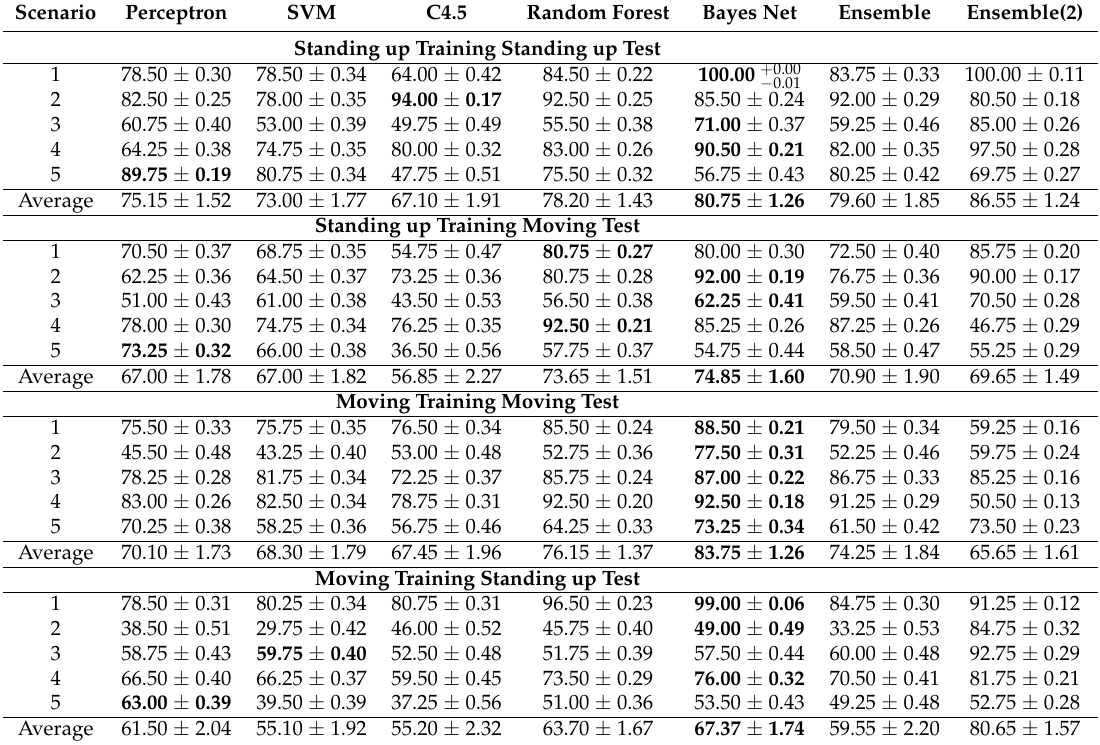
Table 3. Performance results for the five different Machine Learning classifiers (data shown in percentages. Samples for training acquired static samples for testing too. The best result for each scenario is shown in